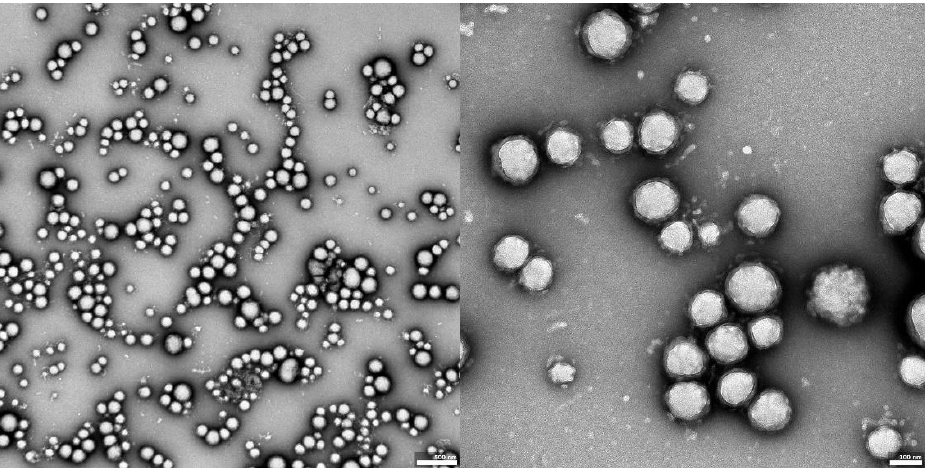
Figure 2. TEM images of UA-PLGA nanoparticles: left panel : UA-PLGA magnitude 10 k, right panel : UA-PLGA Magnification: 40 k. Scale bar 500 nm ( left ), 100 nm ( right ).